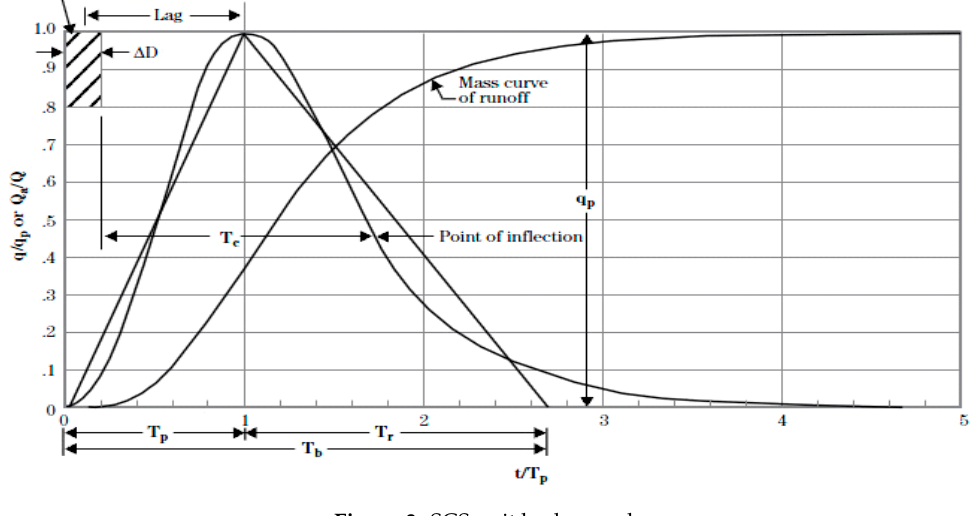
Figure 3. SCS unit Figure 3. SCS unit hydrograph.